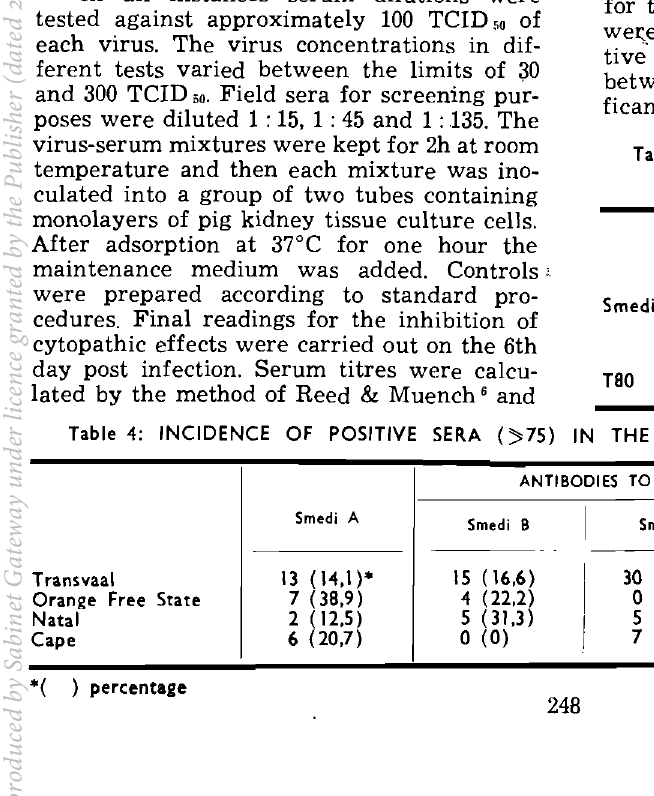
Table 2: HERDS WITH POSITIVE ANTIBODY TITRES (:::'75)